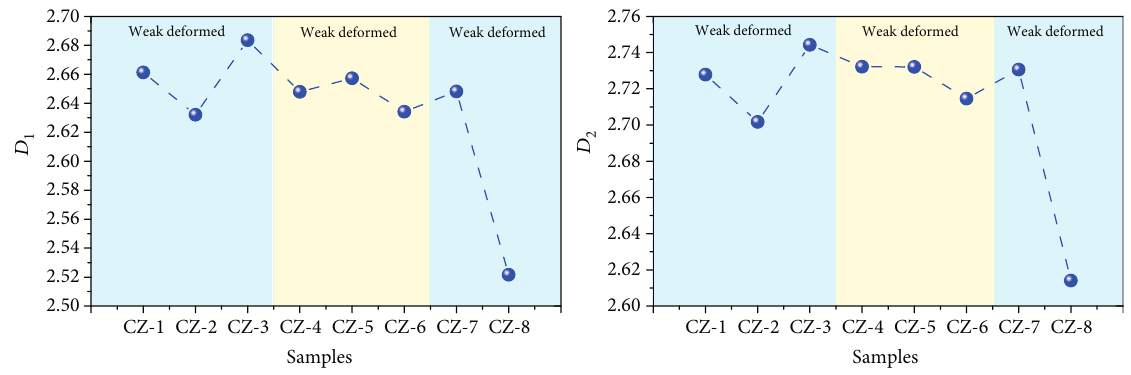
Figure 12: Fractal dimension of the Lujiaping shale from the data of LP-N